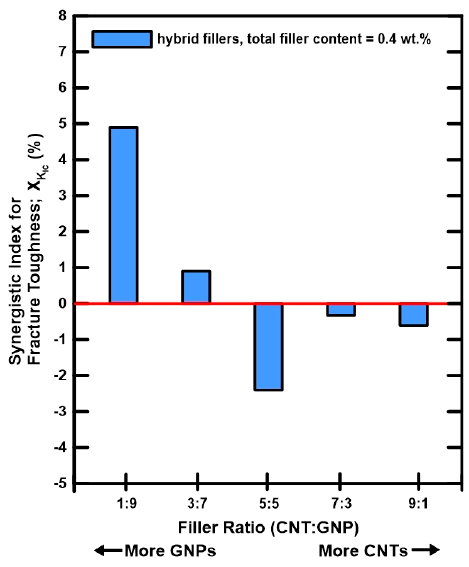
Figure 12. Synergistic indexes χ for the Mode I fracture toughness of the nanocomposites with various filler ratios.